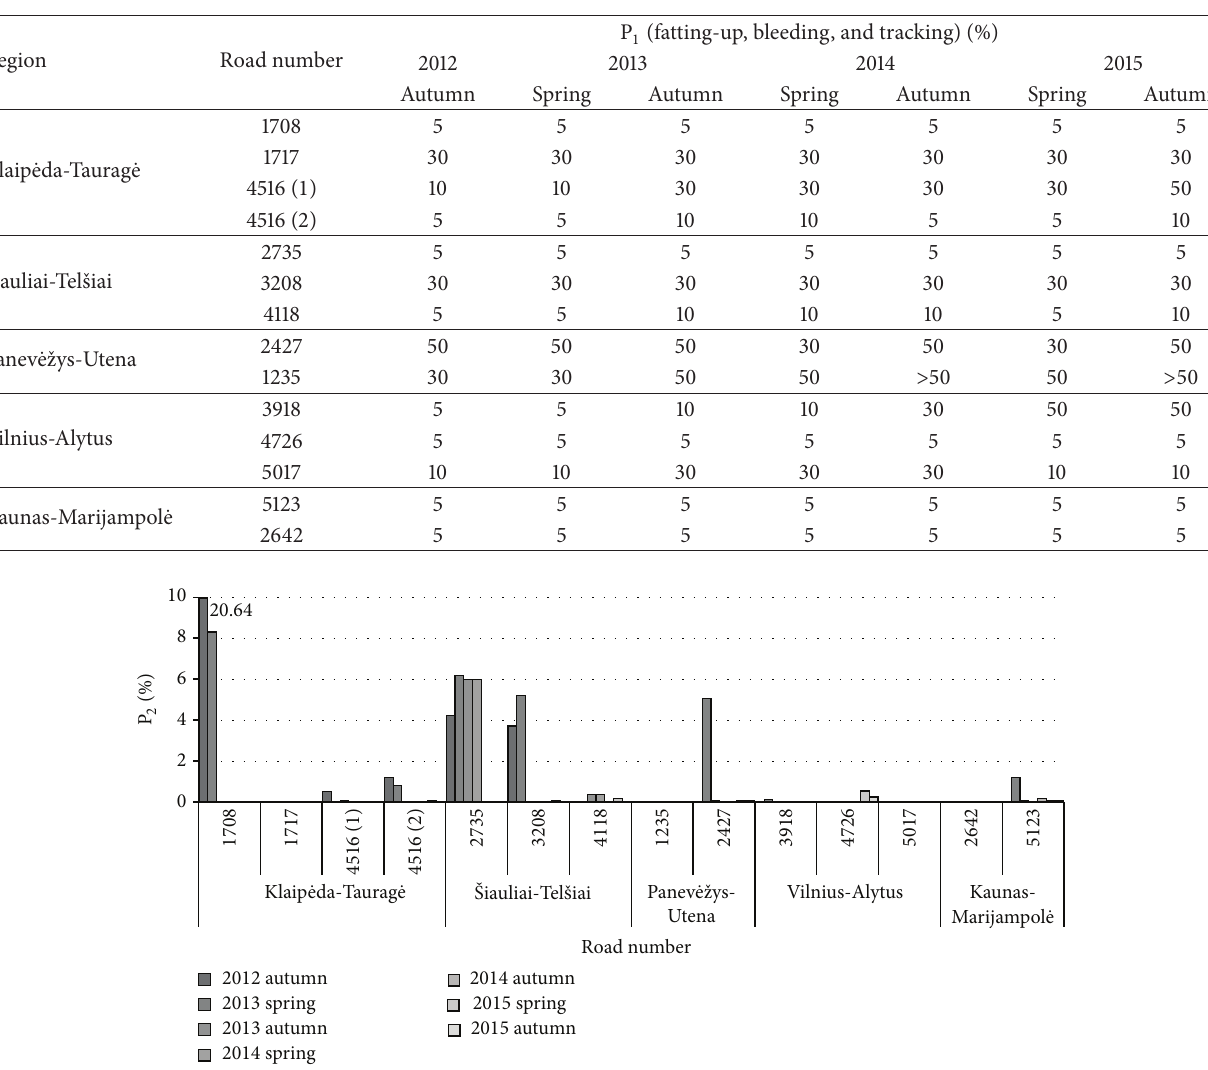
Table 4: P 1 (fatting-up, bleeding, and tracking) on roads section covered with double Otta Seal.